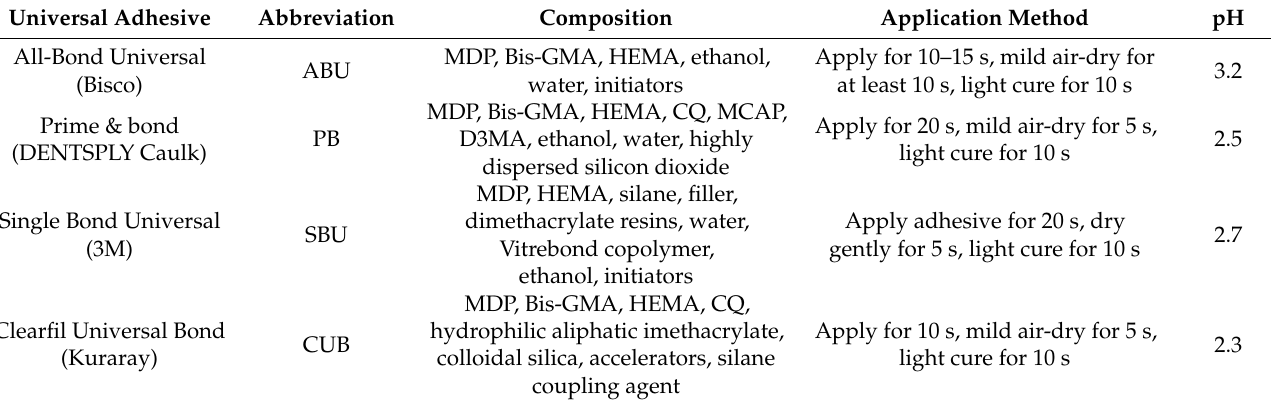
Table 1. Universal adhesives used in the experiment and their application methods.